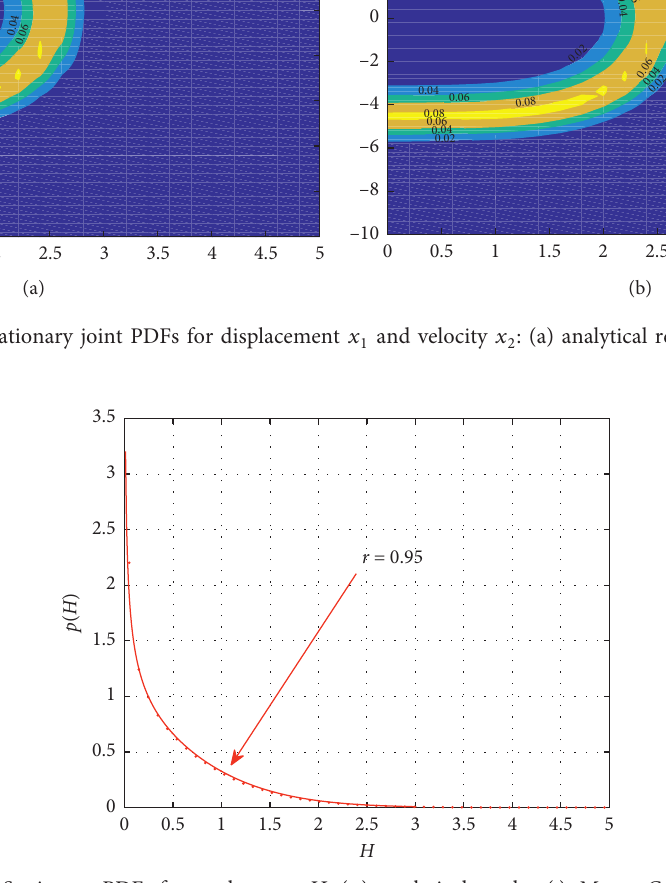
Figure 5: Stationary PDFs for total energy H . ( − ), analytical results; ( · ), Monte Carlo